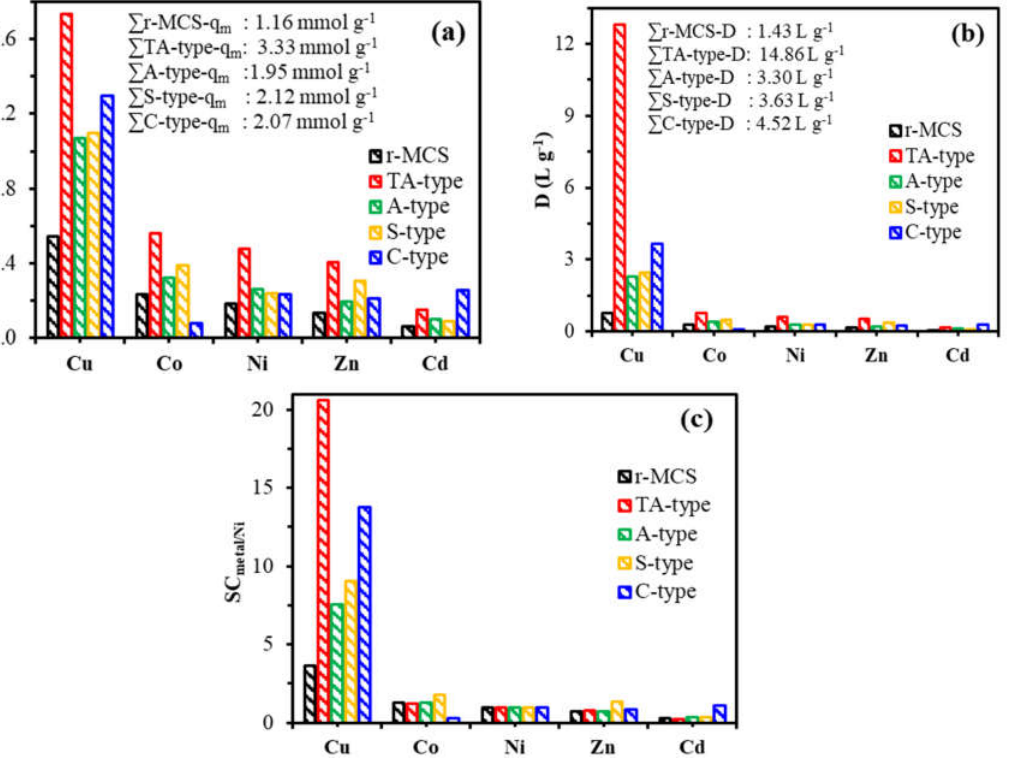
Figure 8. Selectivity experiments through sorption capacities ( a ), distribution coefficients ( b ), and selectivity coefficient (SC metal/Ni ) ( c ): (pH 0 , 5.0; SD, 0.5 g.L −1 ; T, 298 K; time, 120 min; 200 rpm).